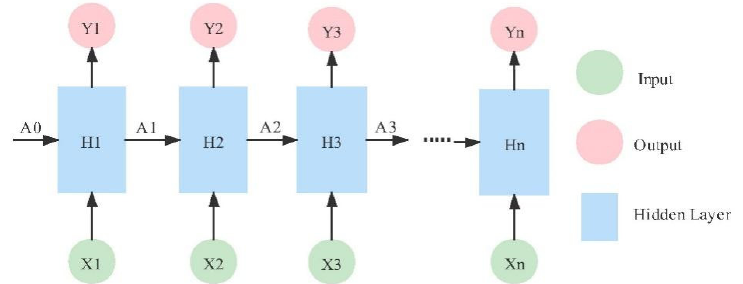
Figure 9. Typical structure of RNN.